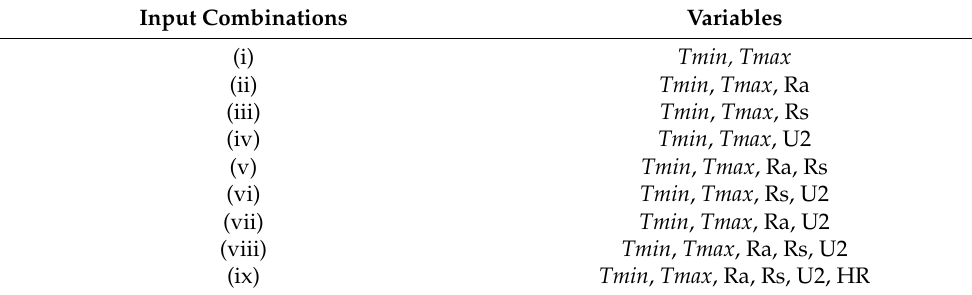
Table 3. The input combinations used for model